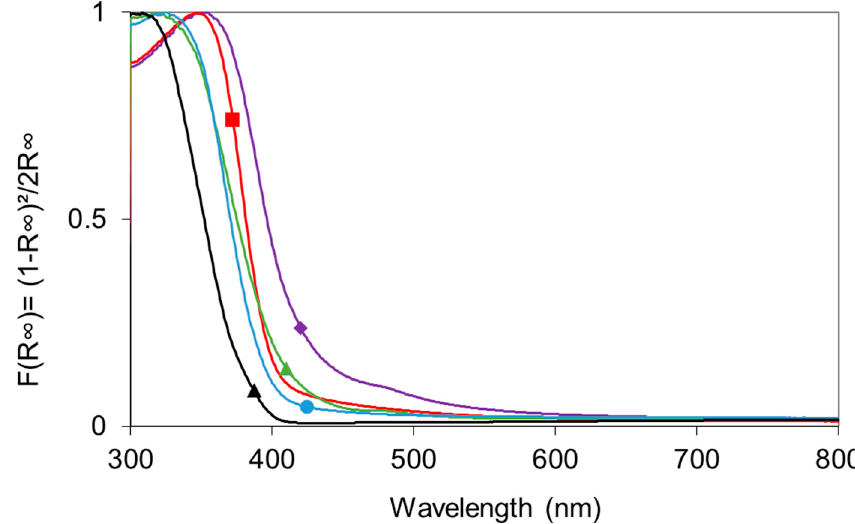
Figure 4. Normalized Kubelka–Munk function F(R ∞ ) calculated from DR-UV-Vis absorbance spectra and transformed via the Kubelka–Munk function for ( ● ) pure TiO 2 , ( ▲ ) TiO 2 /Fe0.5, ( ■ ) TiO 2 /N43, ( ♦ ) TiO 2 /Fe0.5/N43 and ( ▲ ) Evonik